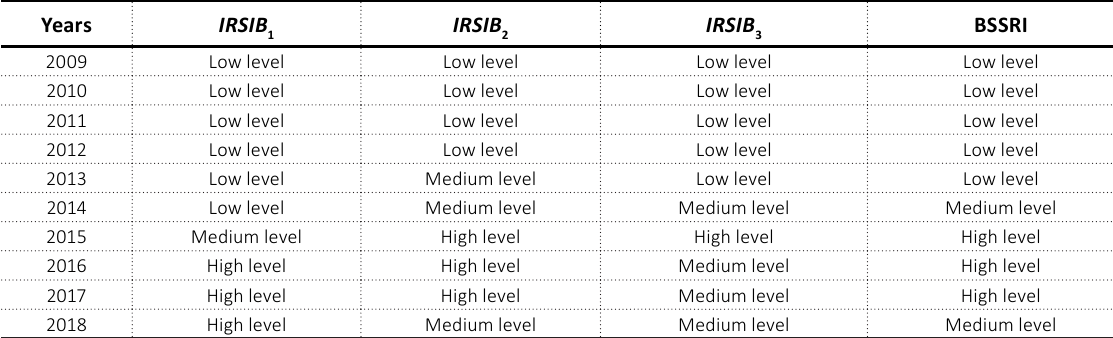
Table 4. Findings illustrating qualitatively interpreted quantitative systemic risk assessment in the Ukrainian banking